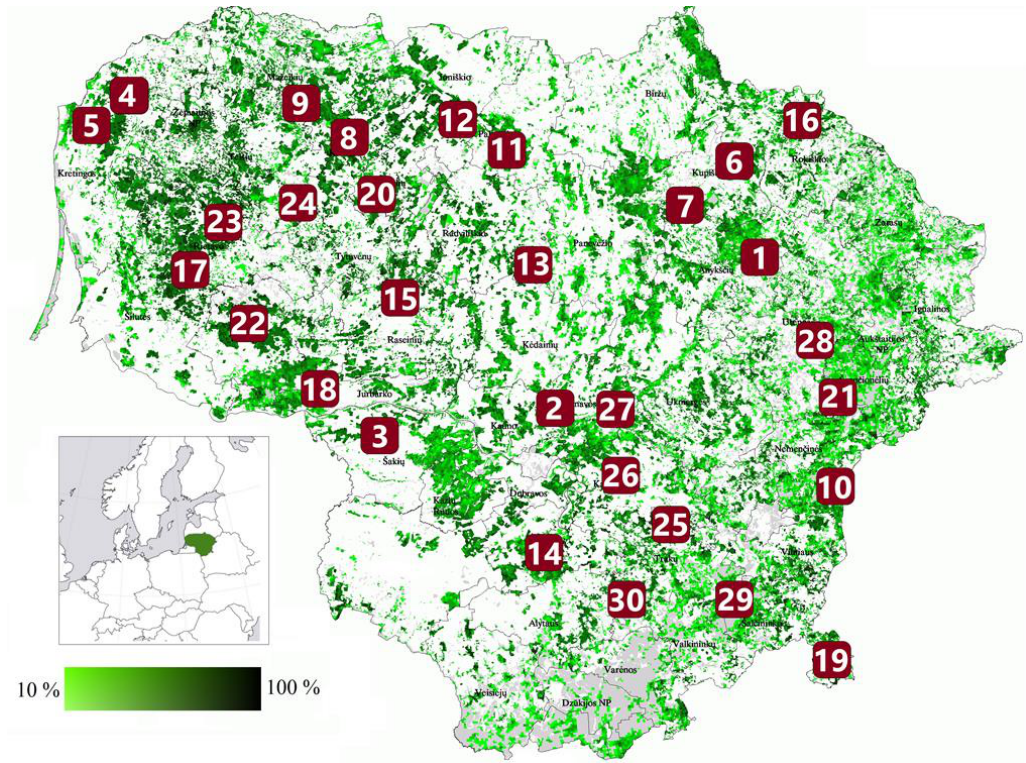
Figure 1. Map of Lithuania (position shown on the north European map in the lower left corner) showing the distribution of Norway spruce ( Picea abies ) forest stands (in green), where sampling of living shoots, needles, roots, and the rhizosphere soil was carried out. The gradient bar shows the percentage of P. abies trees in the composition of forest stands.